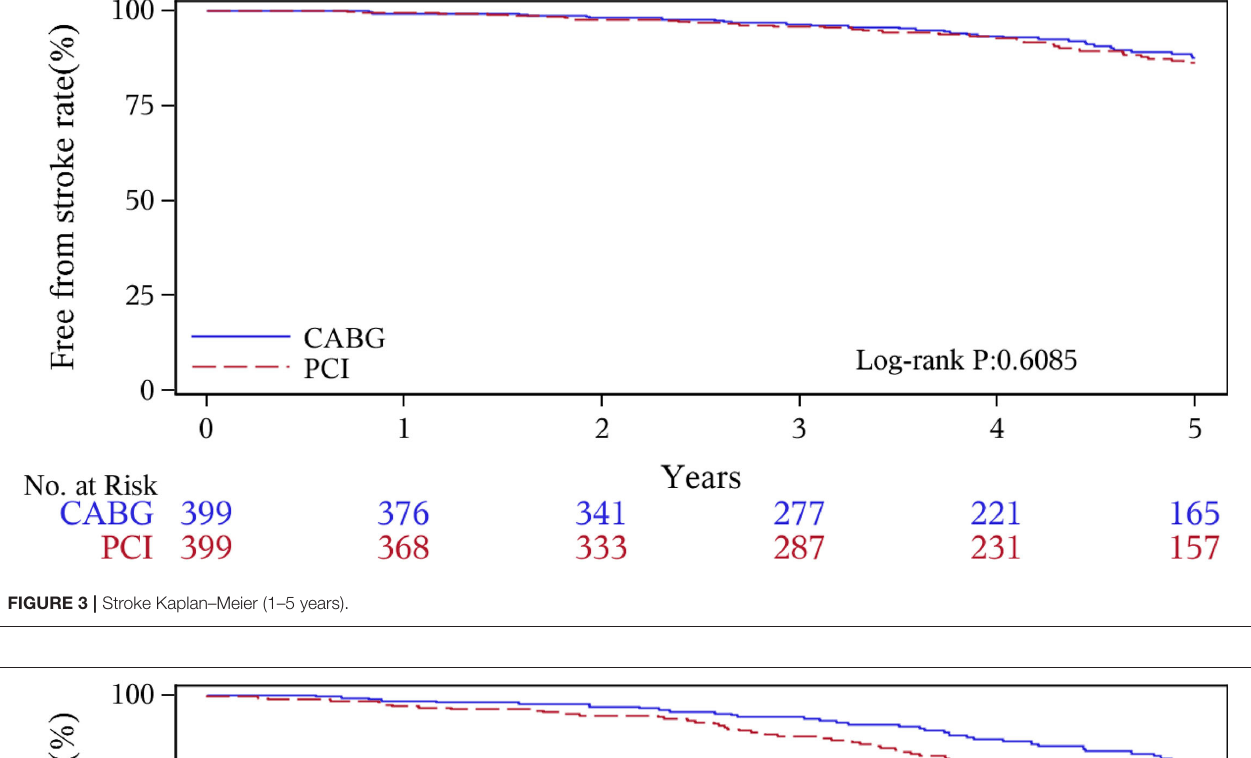
FIGURE 3 | Stroke Kaplan–Meier (1–5 years).